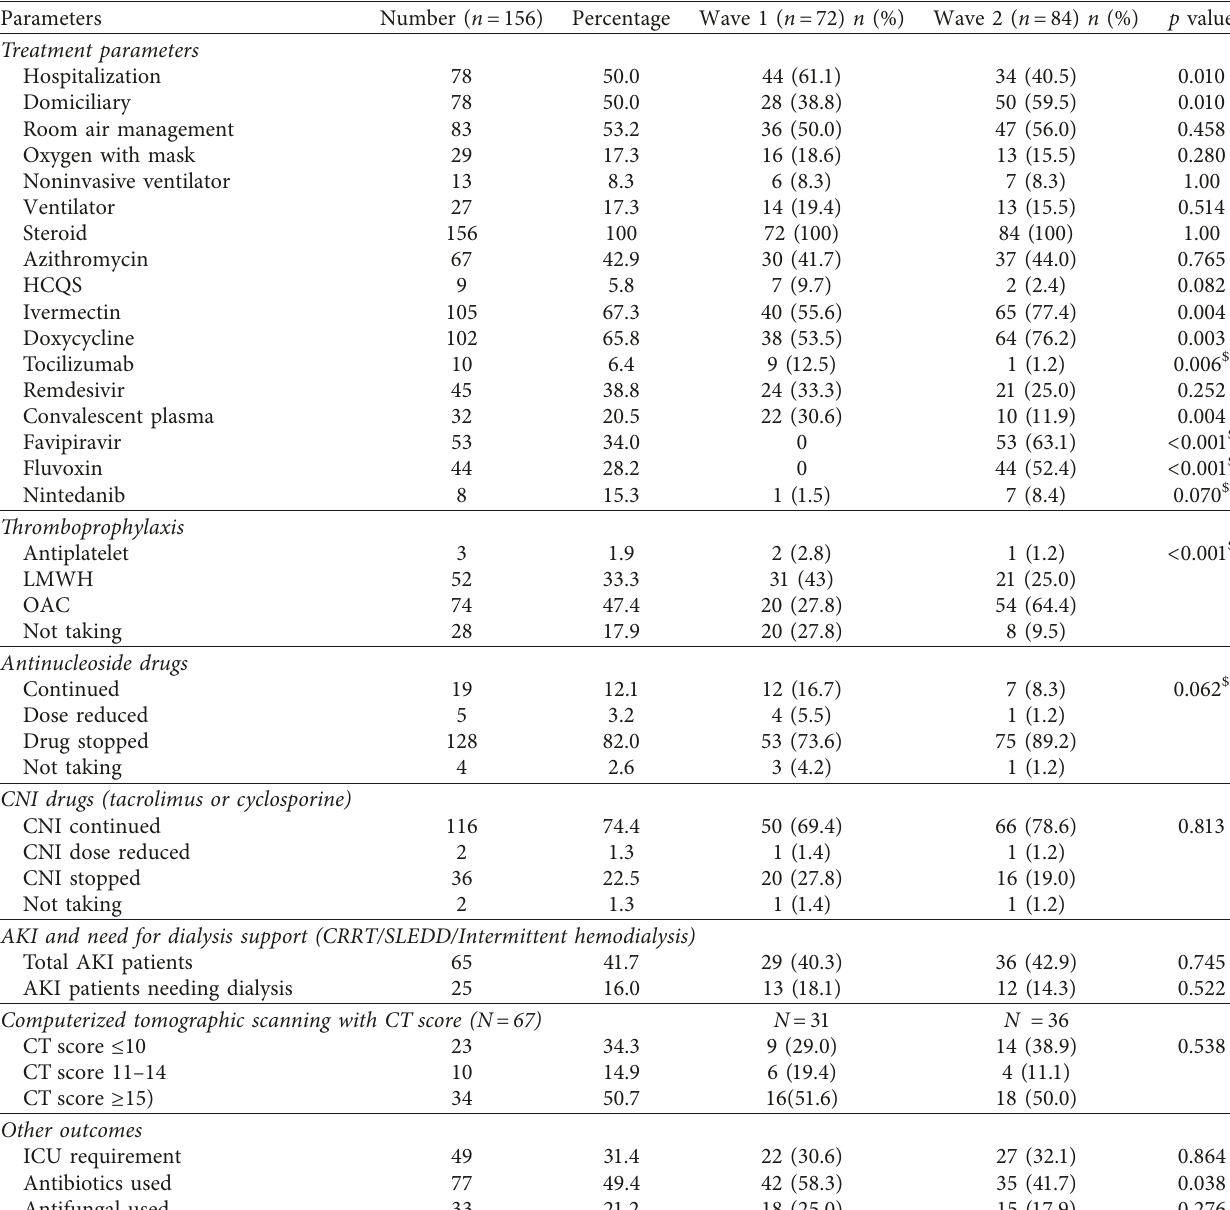
Table 3: Clinical outcome and management of KTRs with COVID-19 in both